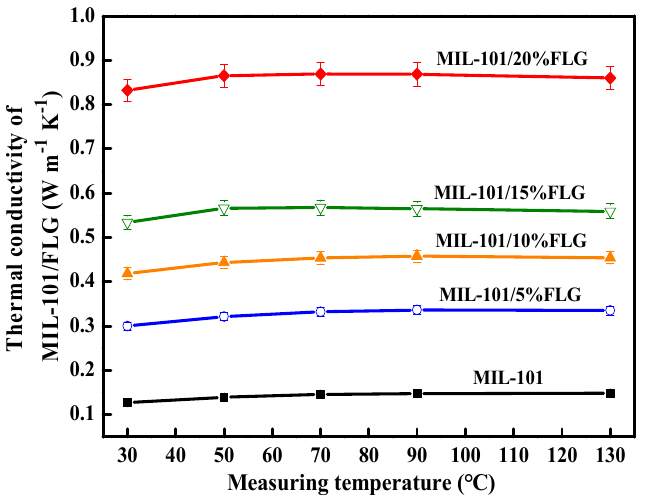
Figure 3. Thermal conductivities of MIL-101/FLG composites and MIL-101 at different measurement temperatures.